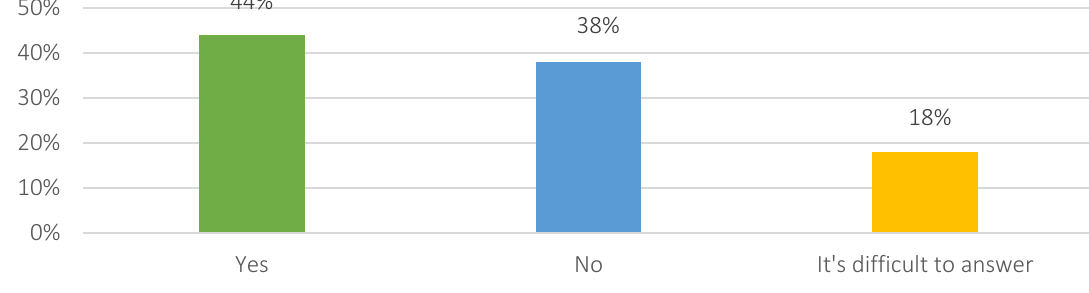
Figure 1. Level of satisfaction with quality of education,